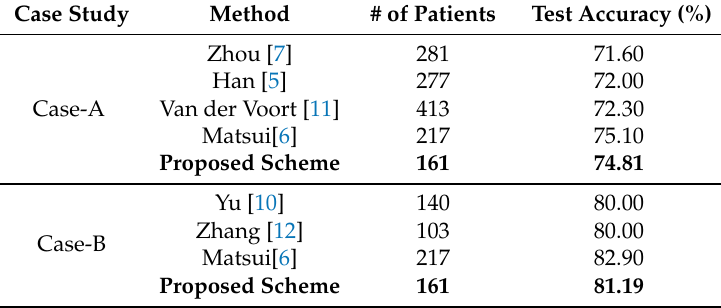
Table 5. Comparison with some existing state-of-the-art performance. It is worth noting that different datasets with different data size mostly from one source, different modalities and scan types were applied, hence these methods can be used as an indication or reference for “good” performance reported so